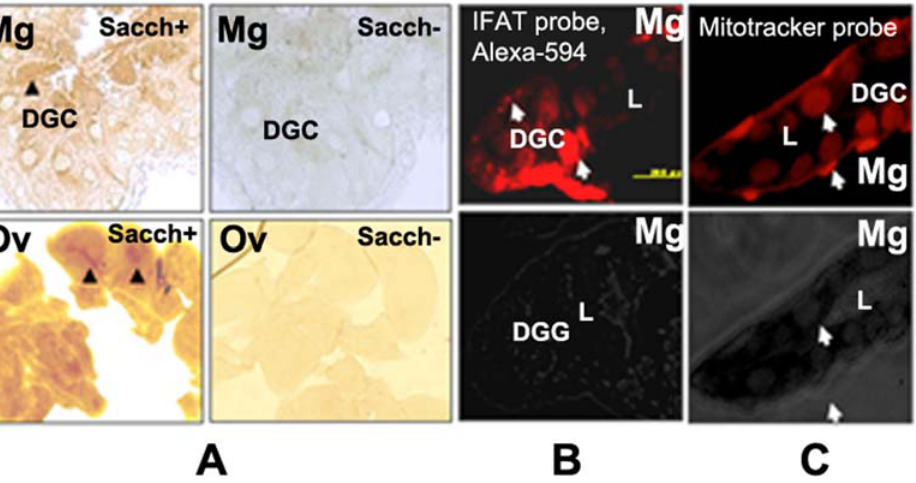
Figure 7. Histochemical detection of SDH activity in sectioned midgut and ovary. A. In the SDH activity staining tissue, slides stained with saccharopine are labeled with ‘‘Sacch + ’’ and control slides not incubated with saccharopine labeled with ‘‘Sacch-’’. Positive reaction shows SDH specific staining as brown dots on the oocytes and digestive cells of the midgut, whereas negative reaction incubated without saccharopine shows no specific staining. Mg, midgut; DGC, digestive cell; L, lumen; Ov, Ovary; Oc, oocyte. B. IFAT; The mouse anti-IgG conjugated with Alexa 594 was used as a secondary antibody. DGC, digestive cell; L, lumen; C. Mitochondria visualization by MitoTracker probe. MitoTracker probe, midgut tissues stained with 50 nM of Mitotracker Red CMXRos. DGC, digestive cell; L, midgut lumen. Magnification, 6 20.